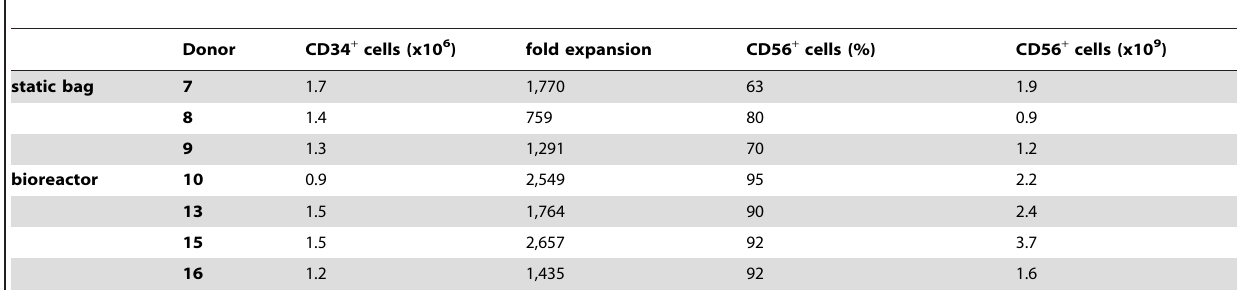
Table 3. Overview of the quantity and quality of final UCB-NK products generated from enriched CD34 + cells using static bags and single use